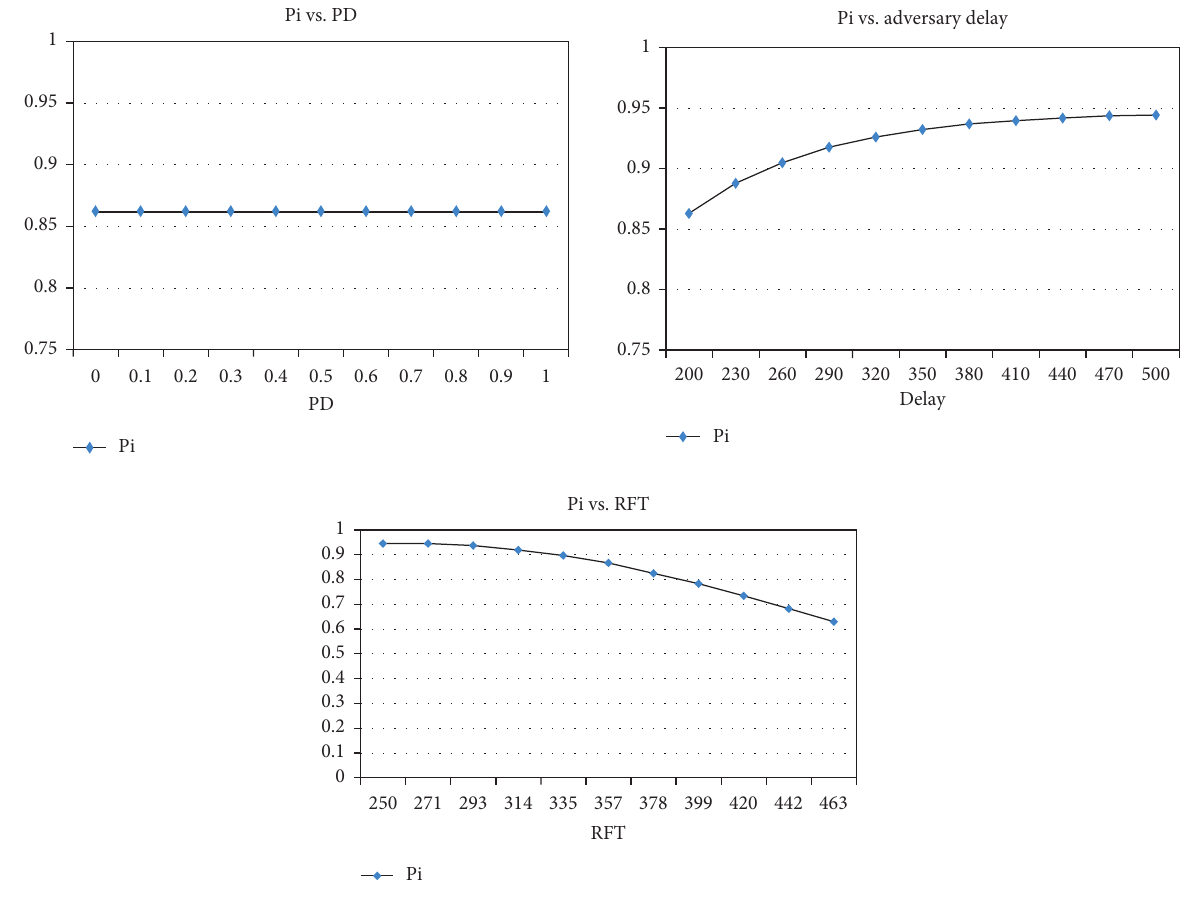
Figure 10: P P I versus D , ADT, and RFT separately for attack scenario 1.3.